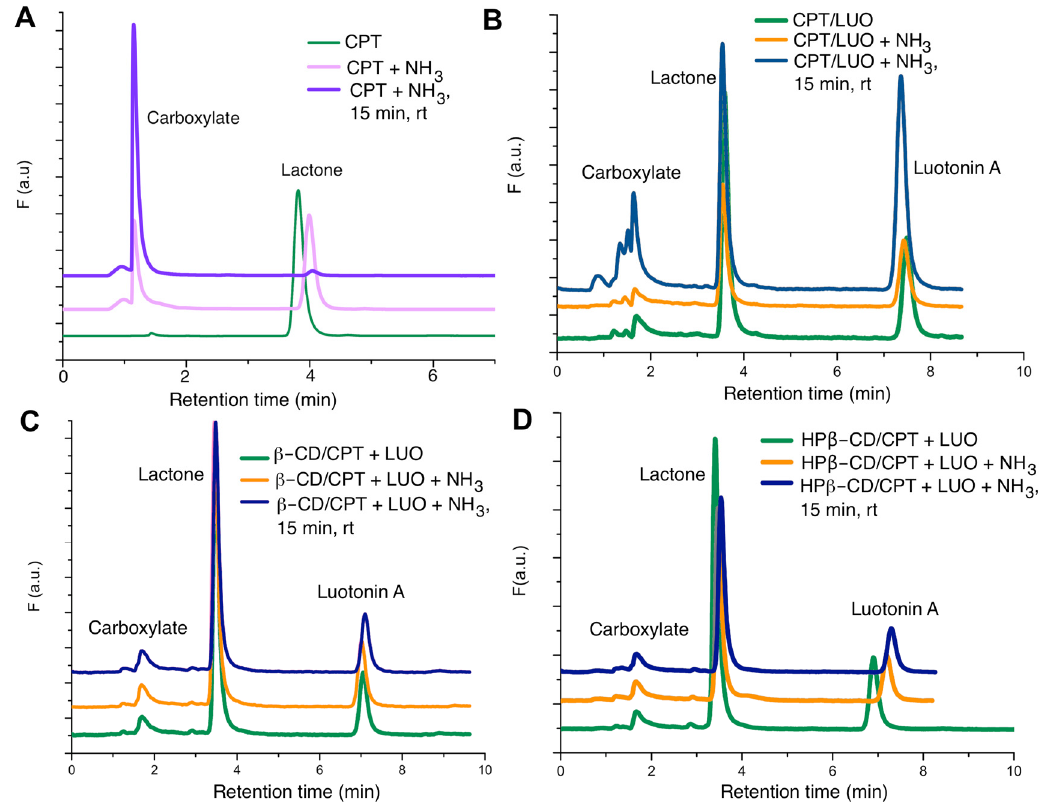
Figure 8. Chromatograms showing that CD complexation protects camptothecin from hydrolysis. ( A ) Hydrolysis of the camptothecin lactone E ring in the presence of aqueous ammonia. ( B ) The same reaction followed by separation in the presence of luotonin A as an internal standard. ( C ) Campothecin hydrolysis in the presence of β -cyclodextrin. ( D ) Campothecin hydrolysis in the presence of HP- β -CD.